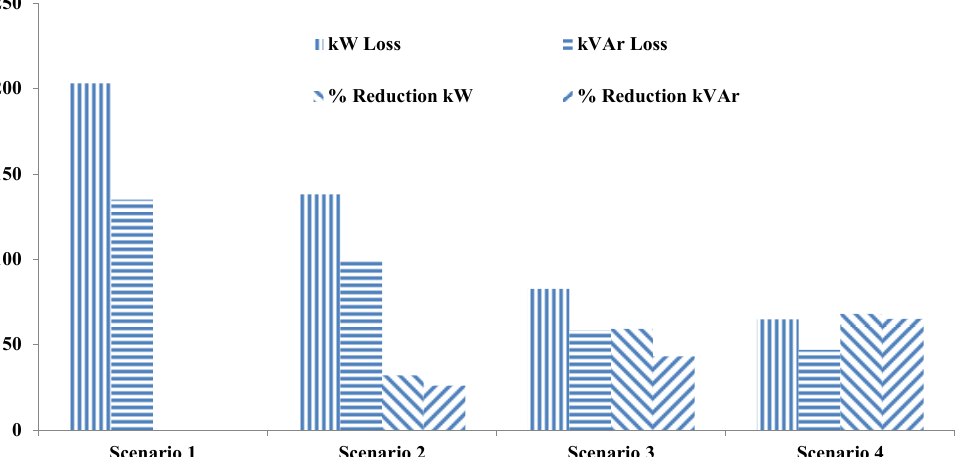
Figure 9. Active and reactive power losses of the network with different scenarios.